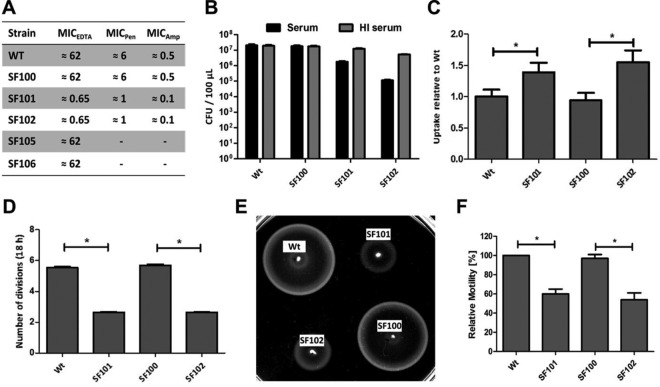
Phenotypic characterization of aroA mutants. (A) MIC values for EDTA (millimolar), penicillin (Pen; micrograms per milliliter), and ampicillin (Amp; micrograms per milliliter) of Wt and aroA-deficient strains SF101 (ΔaroA) and SF102 (ΔlpxR9 ΔpagL7 ΔpagP8 ΔaroA) as well as complemented strains SF105 (ΔaroA p-aroA) and SF106 (ΔlpxR9 ΔpagL7 ΔpagP8 ΔaroA p-aroA). (B) In vitro sensitivity toward human complement. Bacteria (2 × 107) were treated with either untreated or heat-inactivated (HI) human serum for 30 min at 37°C. The lysis effect was determined by plating. (C) Phagocytic uptake of Wt and ΔaroA variants. J774 cells were infected with an MOI of 1, and uptake was determined relative to Wt after 1 h. (D) Intracellular replication of Wt and ΔaroA variants in J774 cells. Cells were allowed to engulf the bacteria as in the experiment depicted in panel C. Infected cells were incubated for 18 h, and the remaining numbers of bacteria were determined by plating. (E and F) Motility was assessed on semisolid agar. Means ± standard deviations are displayed. Results are representative for two independent experiments with 5 biological replicates per group. *, P < 0.05.